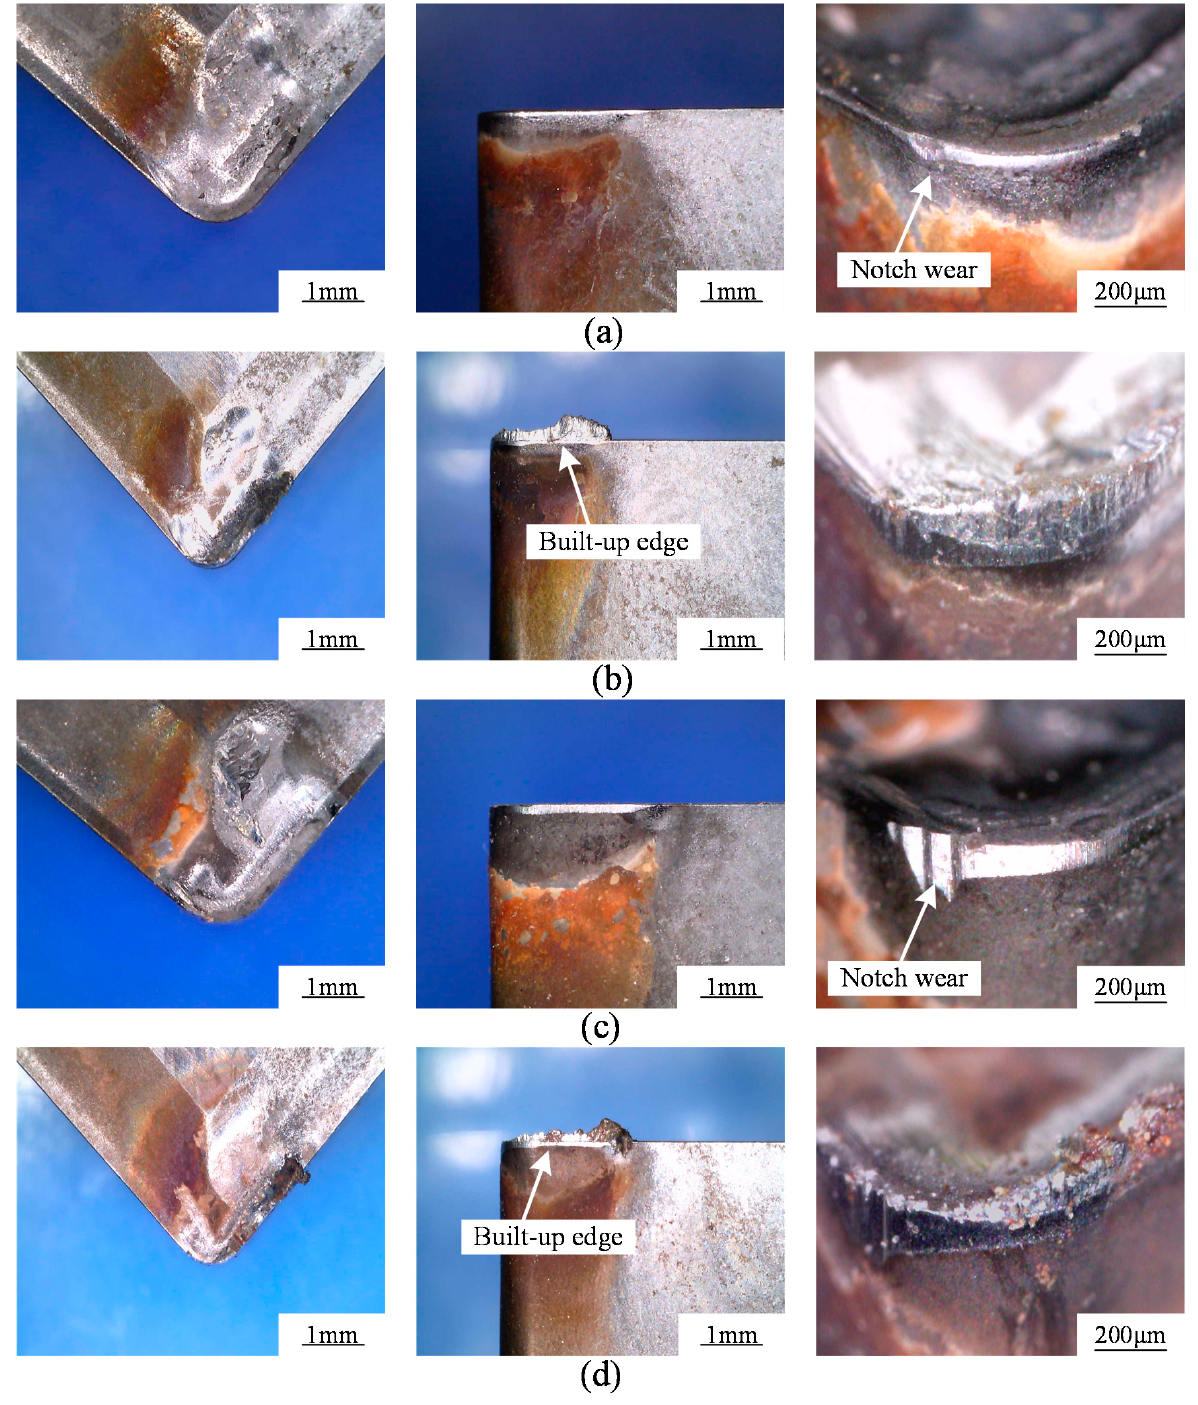
Figure 5. Wear morphologies of cemented carbide tools at both cutting speeds: ( a ) UTi20T and ( b ) A30 at 40 m/min for 41 min, and ( c ) UTi20T and ( d ) A30 at 80 m/min for 15 min.